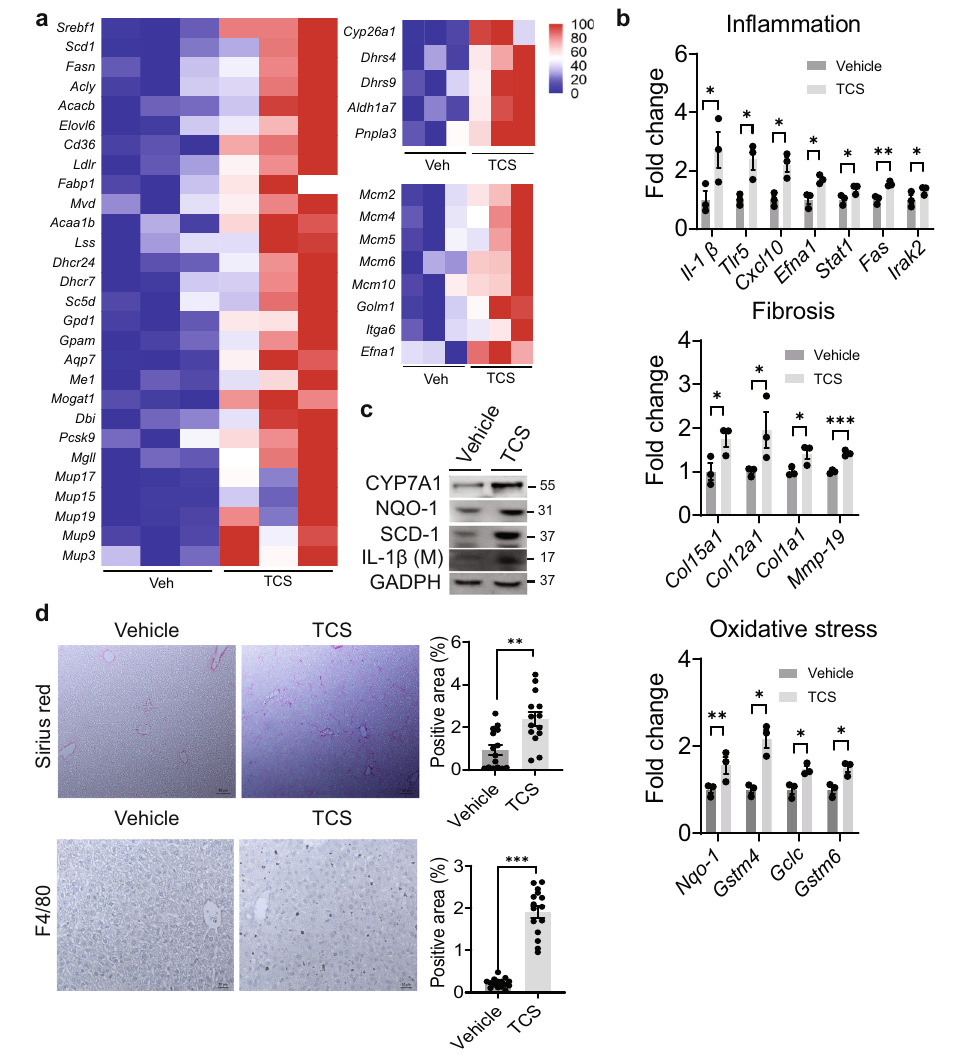
Fig. 3 | TCS induces genes related to NASH and HCC in liver. WT mice breastfed with TCS or vehicle for 21 days. a Heatmaps showing differential expression of genes related to lipogenesis, retinol metabolism and MCM and HCC in 21-day old mice( n =3pergroup). b Expressionofgenesassociatedwithin fl ammation, fi brotic and oxidative stress ( n =3 per group). c Representative IB analysis of NQO1, SCD1 and IL-1 β at 21 days ( n =1 per group). d Histological slides were stained with Sirius